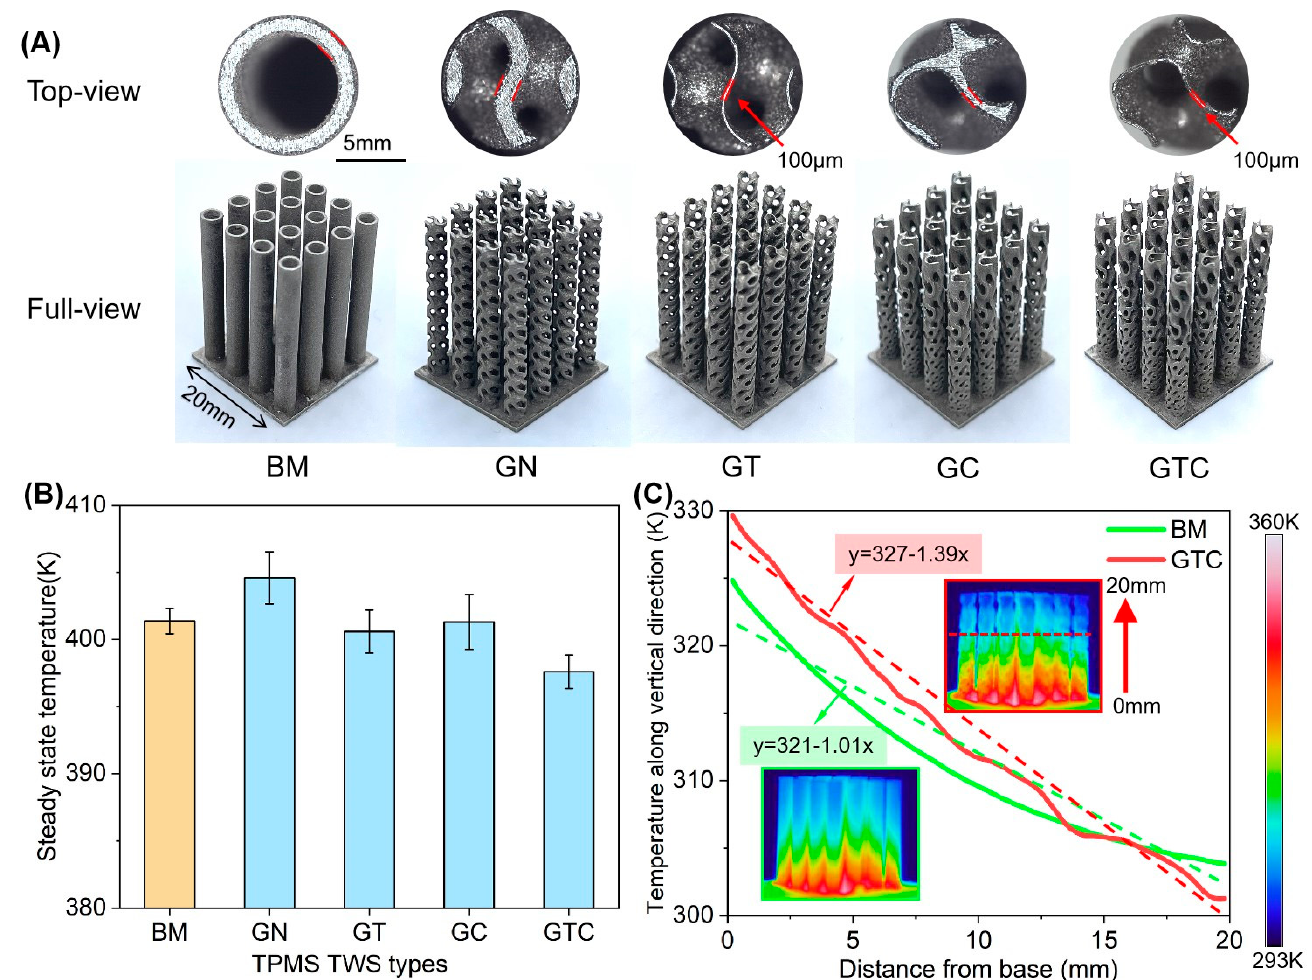
Figure 4. ( A ) As-printed samples of BM and TPMS structures and thickness comparison; ( B ) The steady-state temperature of base cooled by different samples; ( C ) The average temperature curves of cross-section on the vertical direction from heater; temperature distribution measured by an infrared camera as shown in the thermal image inserts.